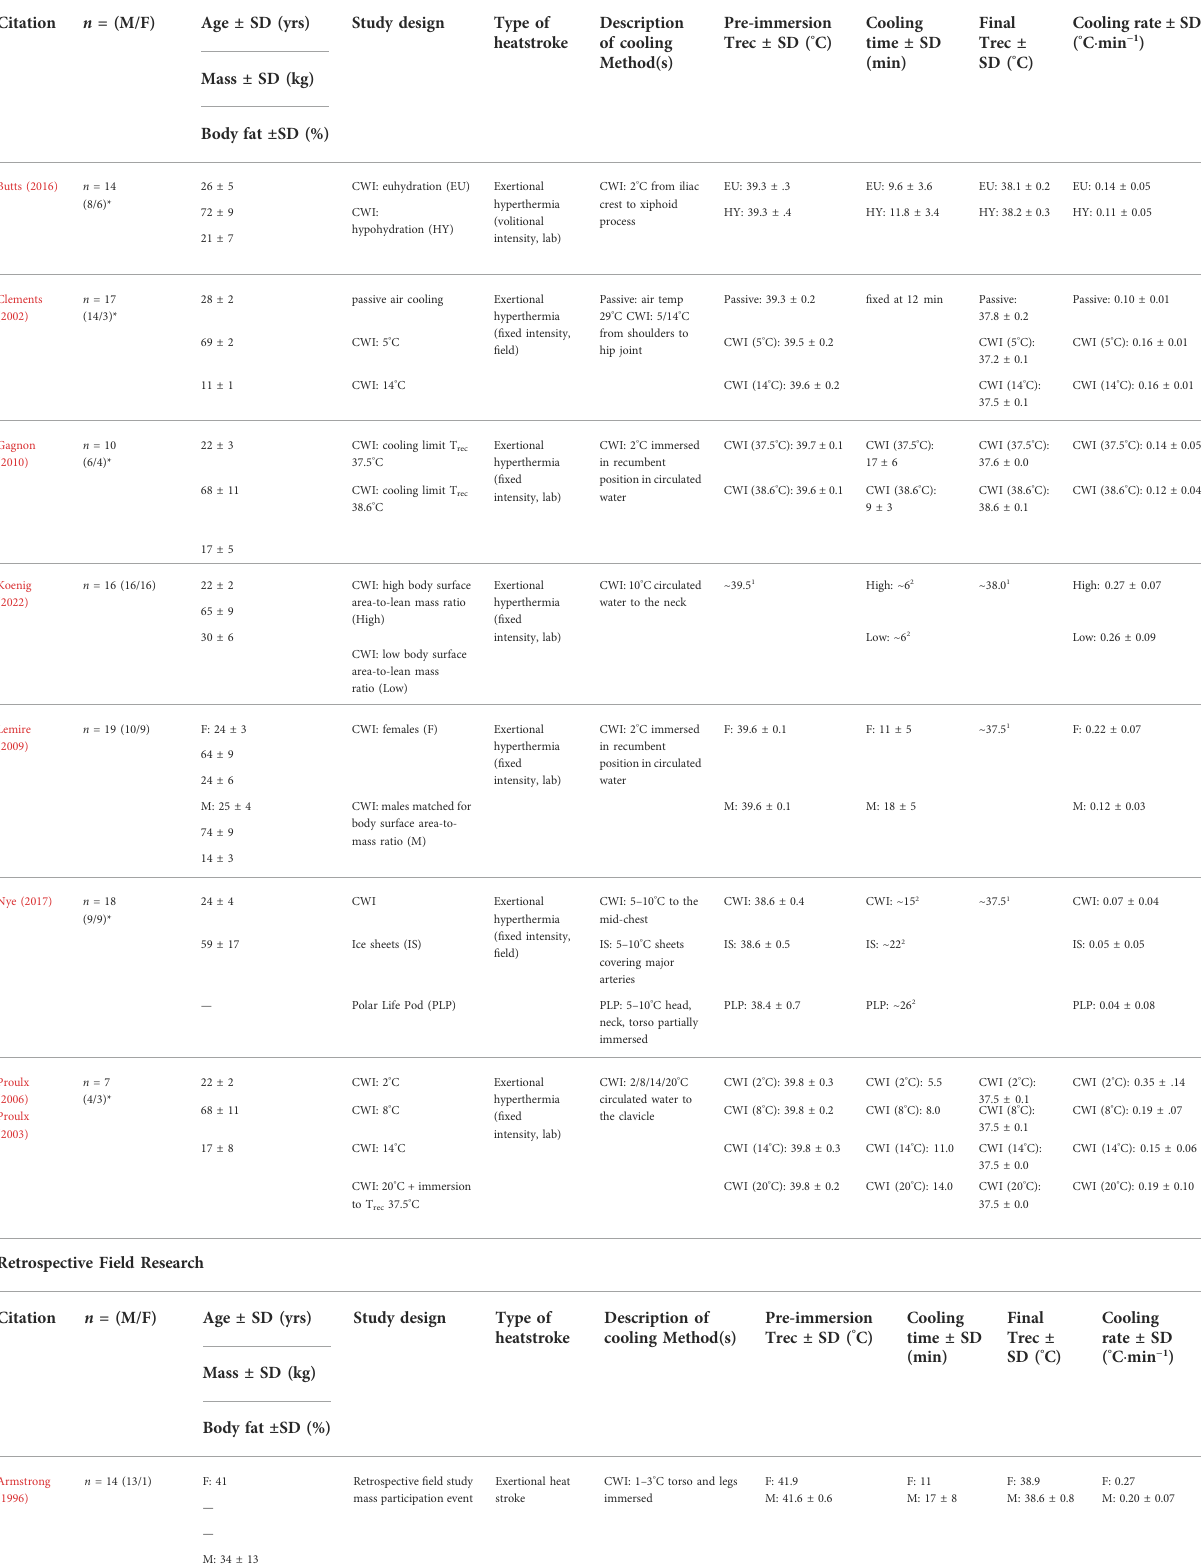
TABLE 1 Study design and results of cold water immersion research involving hyperthermic women or females with exertional heat stroke. Laboratory Research